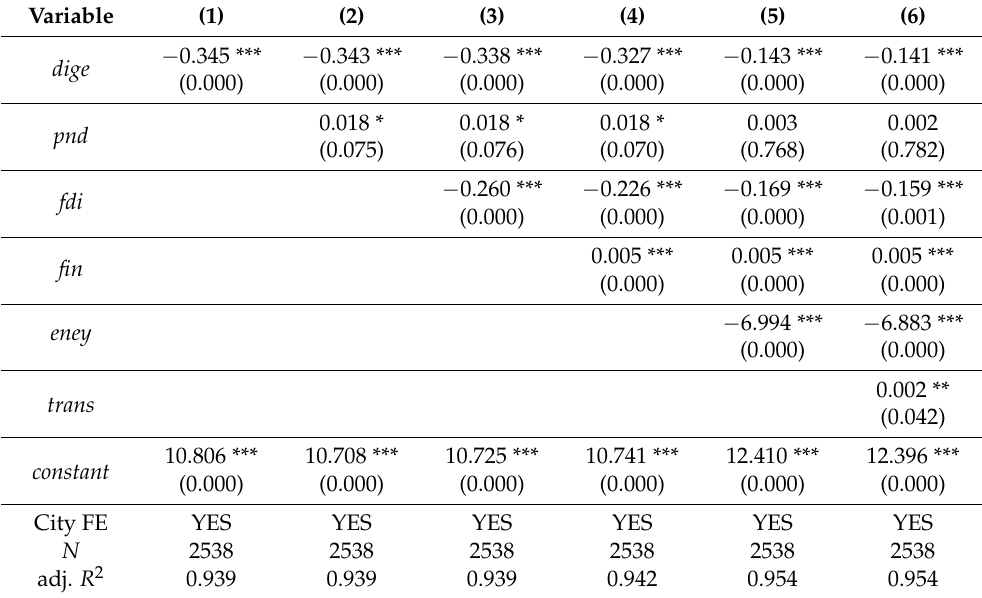
Table 3. Basic regression